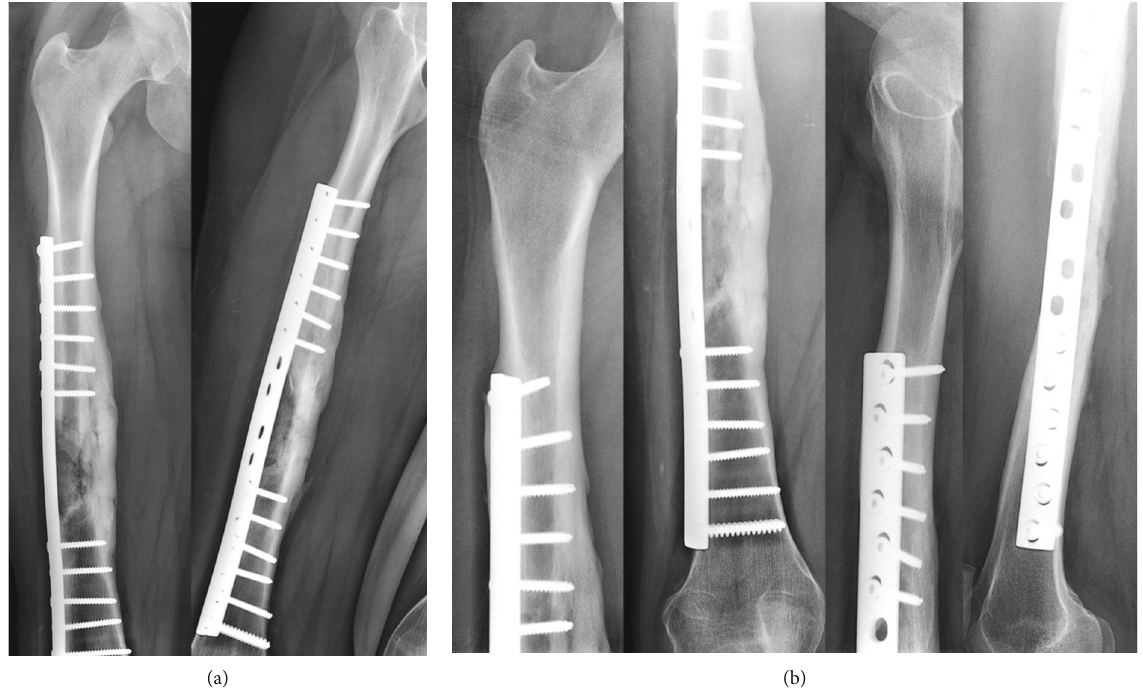
Figure 4: Complete bony union with cortical reconstitution and full integration of the allograft at 60 weeks of follow-up (a). The return to sports activities was authorized after 84 weeks